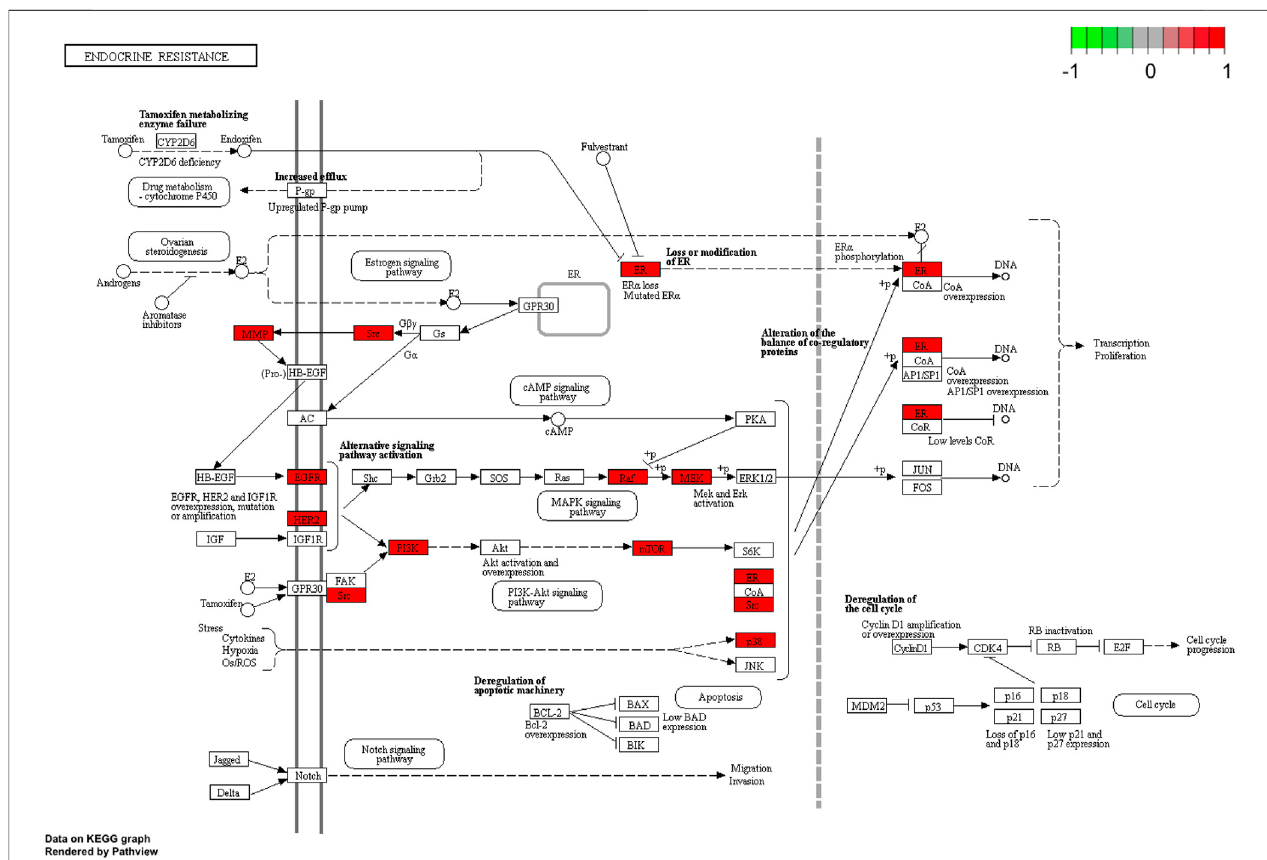
FIGURE 7 | Relevant targets in the signaling pathway of Shan Ci Gu and endocrine resistance. Green and red rectangles indicate unidenti fi ed and identi fi ed proteins, respectively.